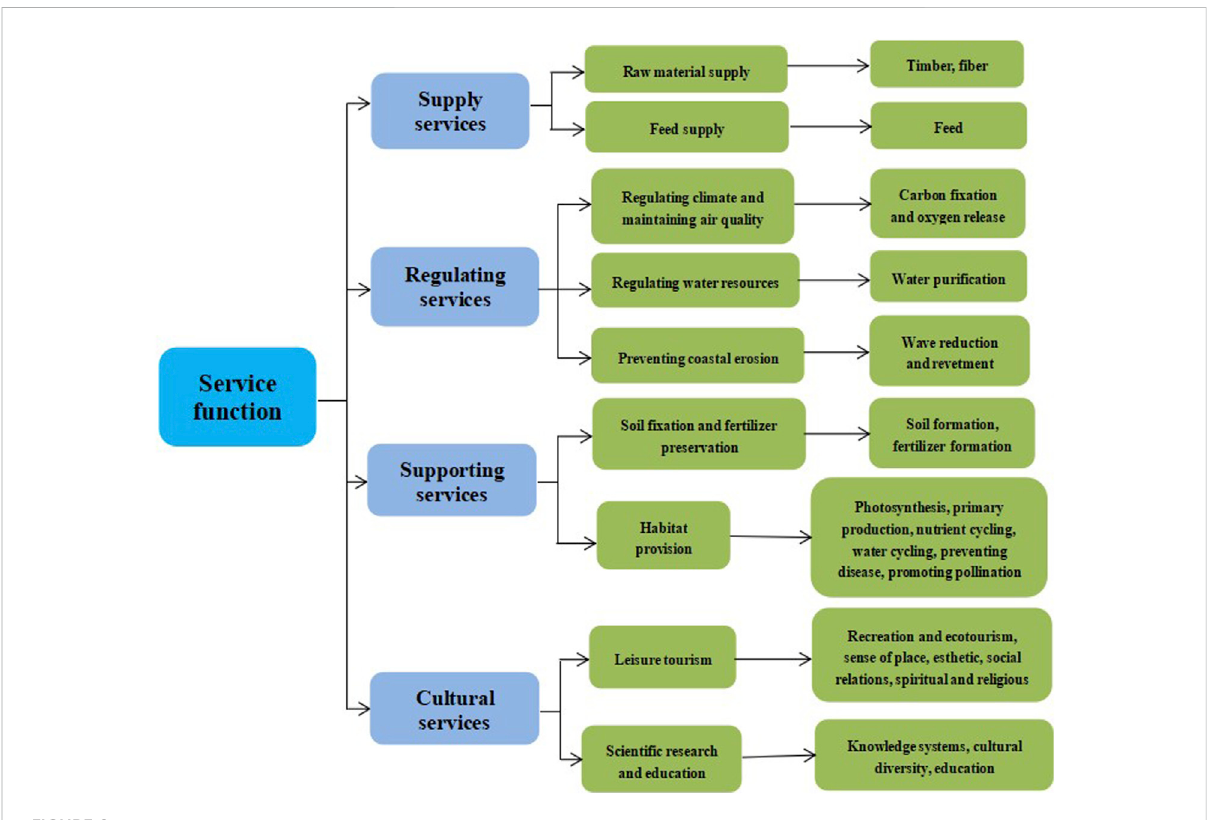
FIGURE 2 Classi fi cation of mangrove ecosystem service